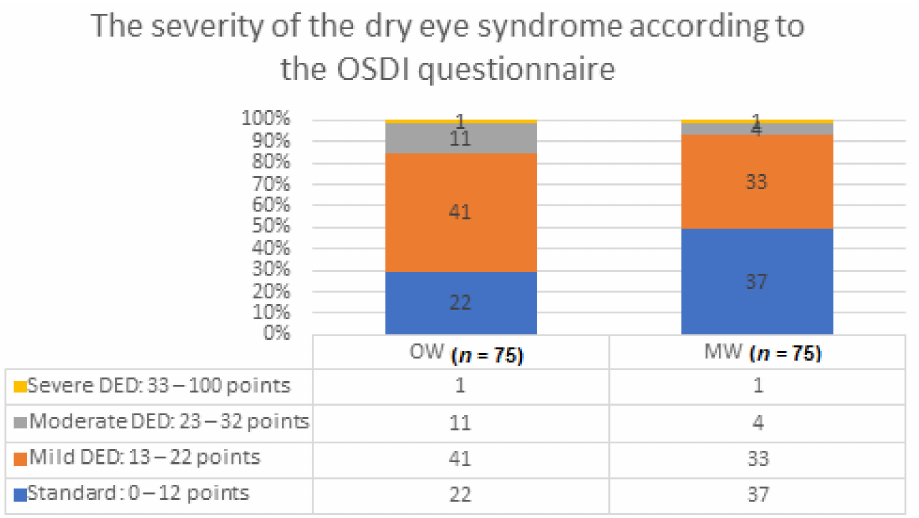
Figure 1. The severity of the dry eye syndrome according to the OSDI questionnaire. Legend: OW group—office workers group, MW group—medical workers group, DED—dry eye disease. 3.2. Selected Parameters of the Eye Surface at Baseline on the First Day of the Examination The groups differed statistically significantly ( p < 0.05) in terms of the mean TMH result before and after work. In the OW group, it was 0.34 mm before work; in the MW group, it was 0.29 mm. The mean TMH result after work in the OW group was 0.29 mm, while in the MW group it was 0.26 mm. The difference of the mean NIKBUT result after work was statistically significant—in the OW group it was 11.18 s; in the MW group it was 12.53. Results are shown in Figure 2 and Table S1 (Table S1 is available in the Supplementary Materials).